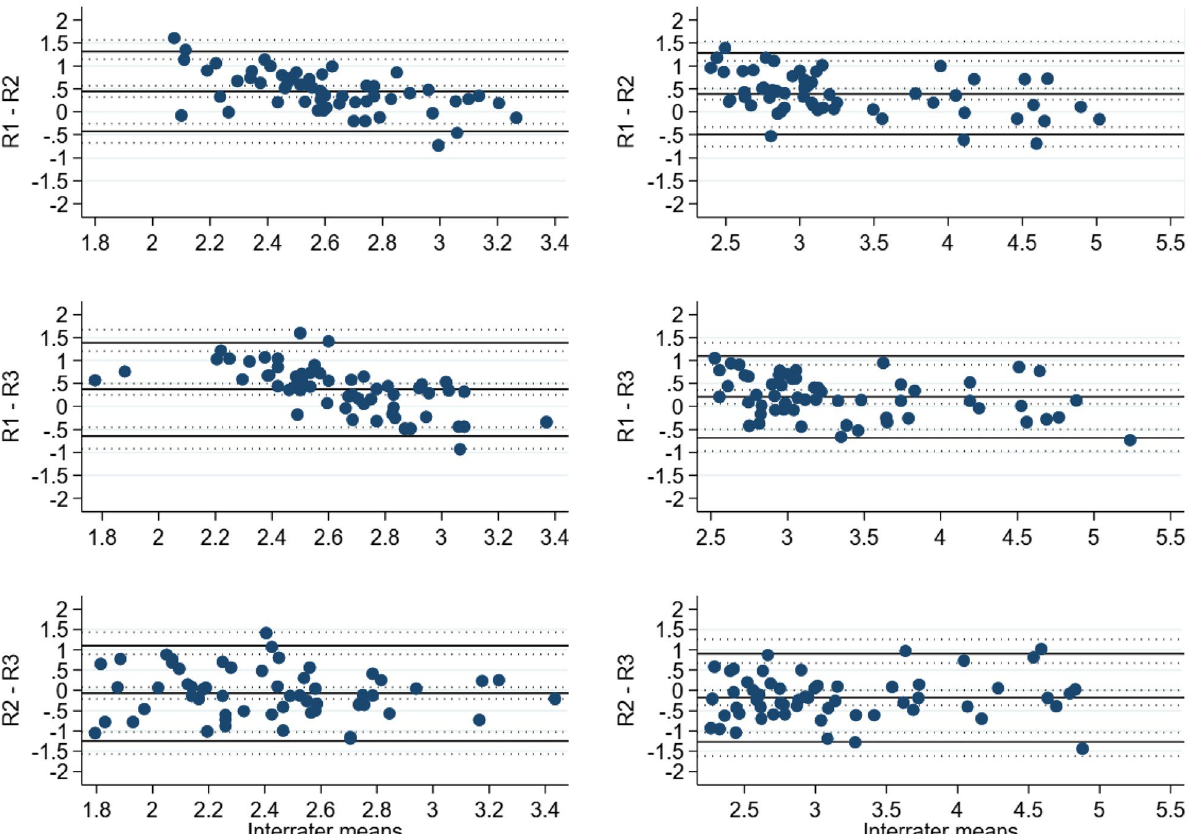
Figure 6. BA LoA plots showing the interrater agreement analysis for electronic caliper [mm]. Left panel: control. Right panel: lymphedema. BA LoA Bland–Altman Limits of Agreement, mm millimeters, R1 rater 1, R2 rater 2, R3 rater